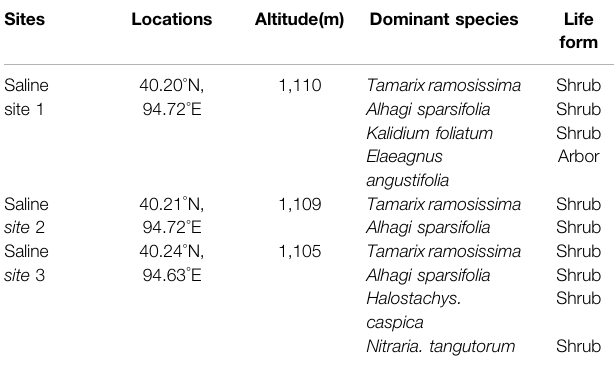
TABLE 1 | Geographic characteristics of study sites, plant species and life